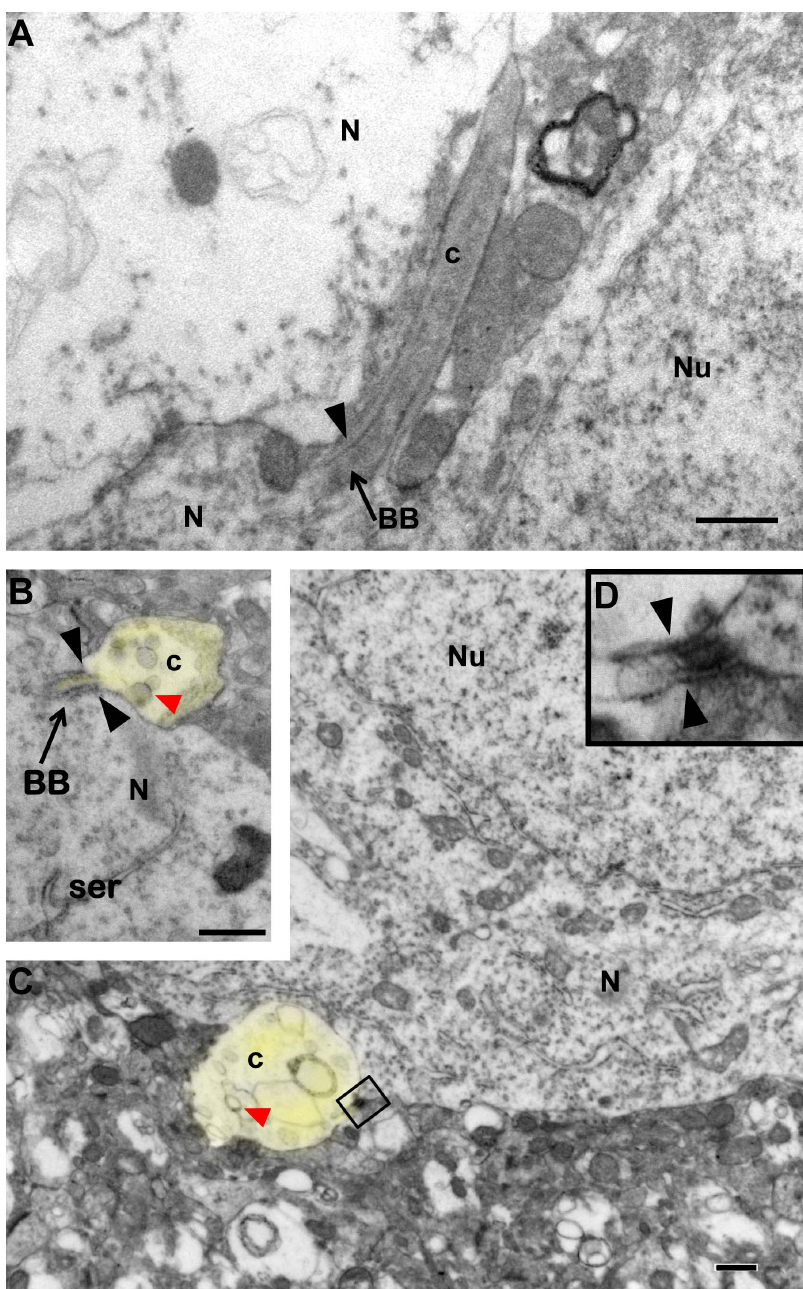
Figure 5. Transmission electron microscopic images of PNC in CA1 hippocampus of WT (A) and Bbs4 -/- mice (B & C). Note the intact basal bodies associated with neurons in WT and Bbs4 -/- mice and abnormal balloon-like cilia starting from basal bodies in B & C compared to healthy PNC with microtubules in A. The insert (D) is a higher magnification image of the area incorporated in the rectangle on (C). The yellow highlights the shape of PNC in Bbs4 -/- hippocampus. The data was collected from three WT and five Bbs4 -/- mice. BB – basal bodies; c – cilium; N - neuron; Nu – nucleus; arrows point to BB; solid arrow heads point to the ciliary transition zones; red arrow heads point to the spherical inclusion bodies. Scale bars: 0.5 m m for